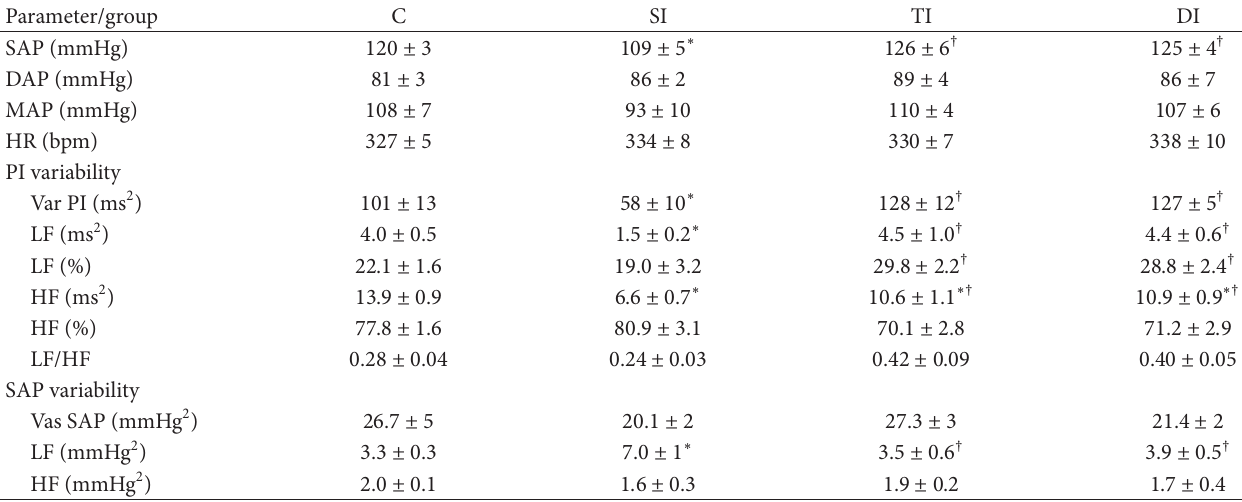
Table 1: Hemodynamic evaluation, pulse interval, and systolic arterial pressure variability in control (C), sedentary infarcted (SI), trained infarcted (TI), and detrained infarcted (DI) rats. Parameter/group C SI TI DI